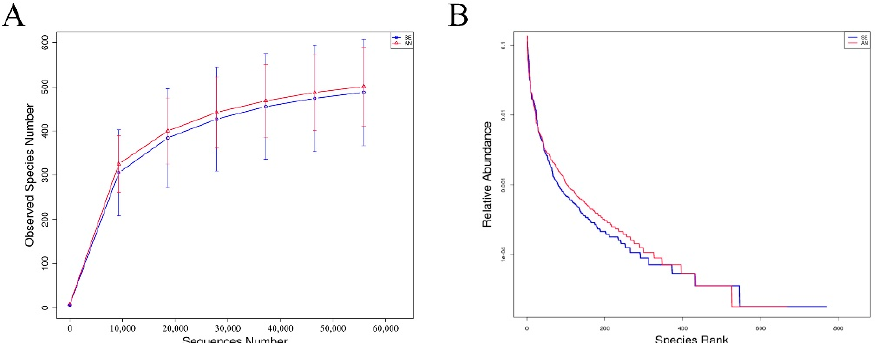
Figure 4. Observed species ( A ) and rank abundance ( B ) of identified OTUs in AN (red) and SE (blue) samples.